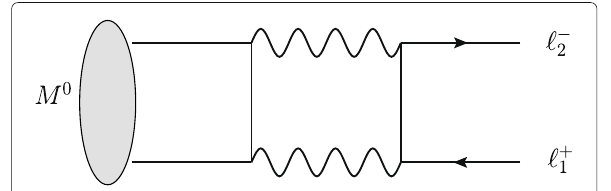
Fig. 2 Flavor violating leptonic decay of neutral mesons